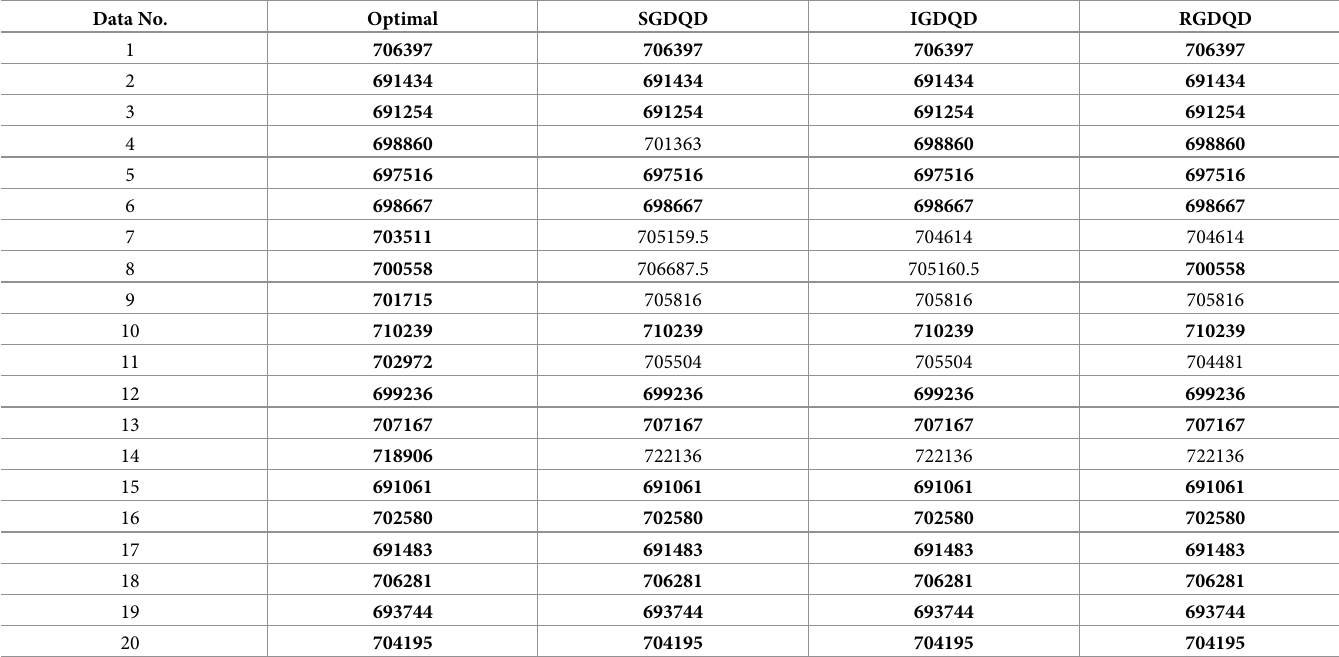
Table 9. Solutions for Q = 75000. Data